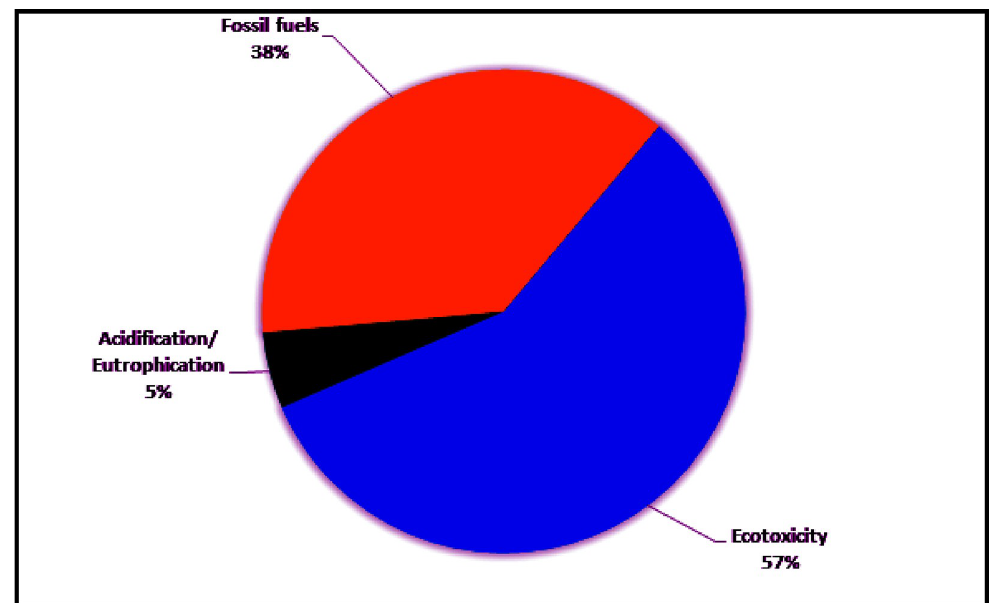
Fig 3. Percent contribution of biodiesel production chain to environmental impact categories.